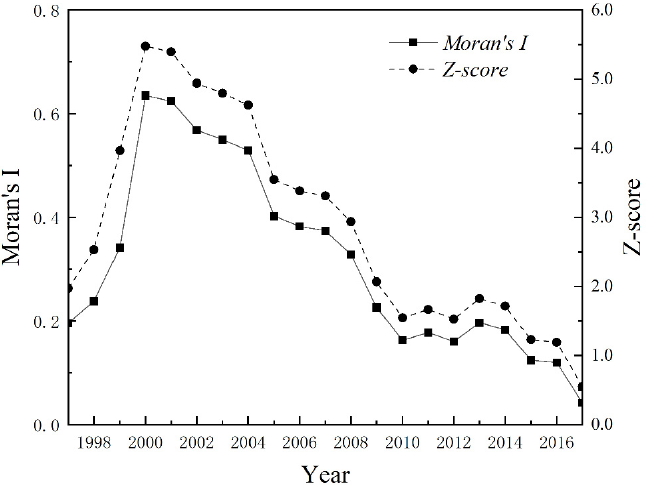
Figure 6. Variation of Moran’s index of carbon emission intensity in the Yangtze River Delta from 1997 to 2017. The carbon emission intensity of cities in the Yangtze River Delta has a strong posi- tive spatial correlation. Therefore, the spatial aggregation state and its dynamic evolution law of the carbon emission intensity of cities in the Yangtze River Delta can be further analyzed. The spatial aggregation state distribution of cities in the Yangtze River Delta is given in Figure 7. Figure 7 shows that except for 2017, the carbon emission intensity in the Yangtze River Delta decreases from the north to the south, forming a high aggregation in the north and a low aggregation in the south, showing a significant aggregation state, which is consistent with the spatial autocorrelation of the mineral resources and economic conditions in the north and the south. Cities in coastal areas develop green economies, and the carbon emission intensity is correspondingly reduced. It is a low aggregation state. The comparison of carbon emission intensity from 1997 to 2017 shows that there are noticeable differences in distribution patterns in different years. Since 2005, Suqian City, Xuzhou City, Lianyungang City, and Bozhou City have been at a high level, indicating that the energy consumption and industrial structure of these cities have not been effec- tively improved, while Hefei, the provincial capital city, has been at a low and high level for a long time. It shows that it has not been able to drive the neighboring cities to decouple economic growth from environmental pollution. Seven cities with low concentrations in 1997 decreased year by year, and there were no cities with a low concentration in 2017. From this, it can be seen that the center of the minimal pattern initially shifted to the north and finally disappeared.